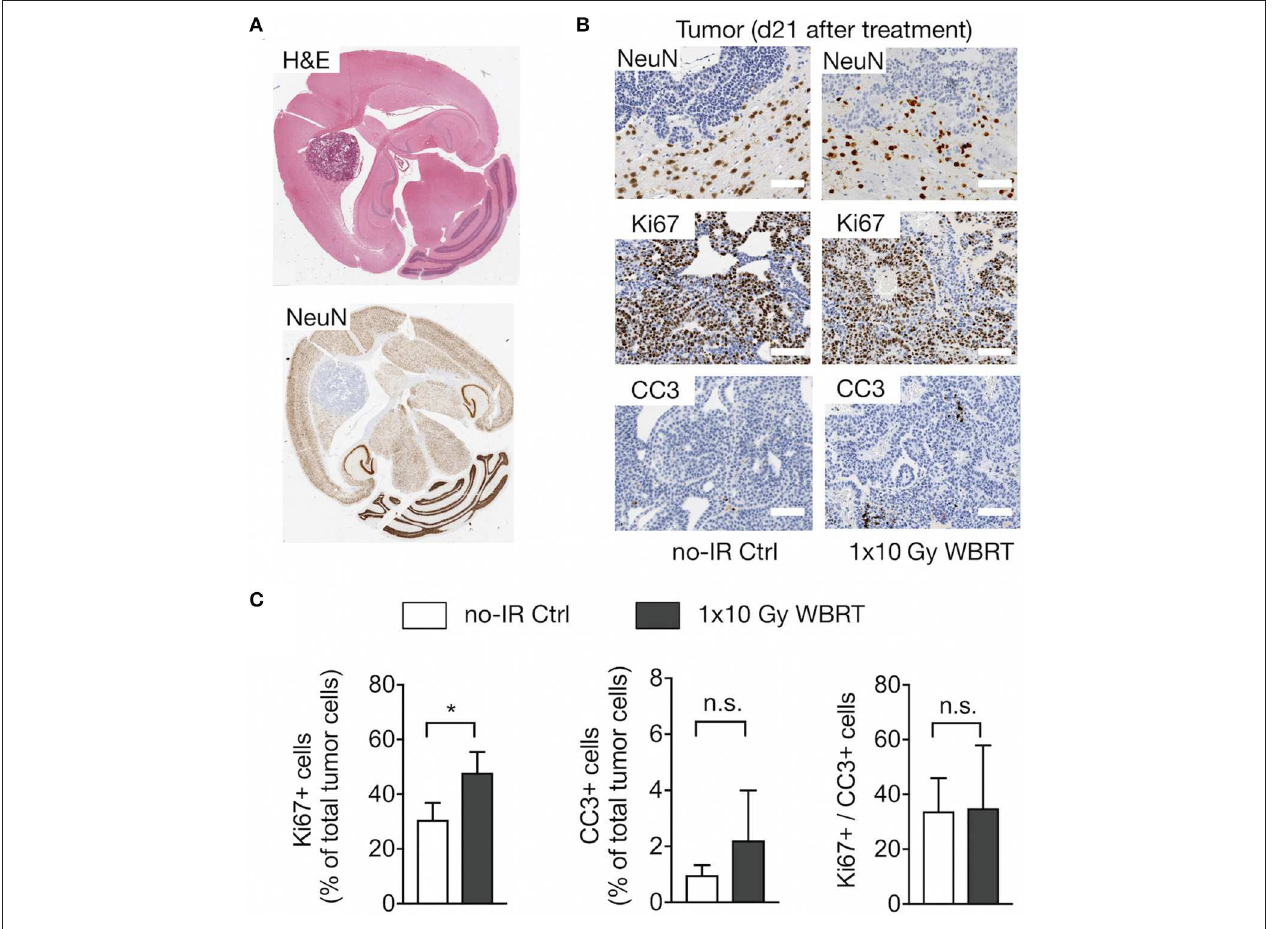
FIGURE 7 | Histopathological assessment. (A) Overview of the localization of neurons in brain metastasis shown by H&E and NeuN staining to detect neurons. (B) Higher magnification images of NeuN + neurons at the tumor-stroma interface, Ki67 + proliferating tumor cells and CC3 + apoptotic cells in brain metastatic lesions in tumor-bearing mice with and without WBRT. Scale bars indicate 100 µ m. (C) Quantification of proliferation and apoptosis rate and the proliferation/apoptosis index in mice with and without WBRT ( n = 4 for each group in both graphs). Data are presented as mean ± s.d.. P -values were obtained using unpaired two-sided Student’s t -test. n.s. = not significant, * P <